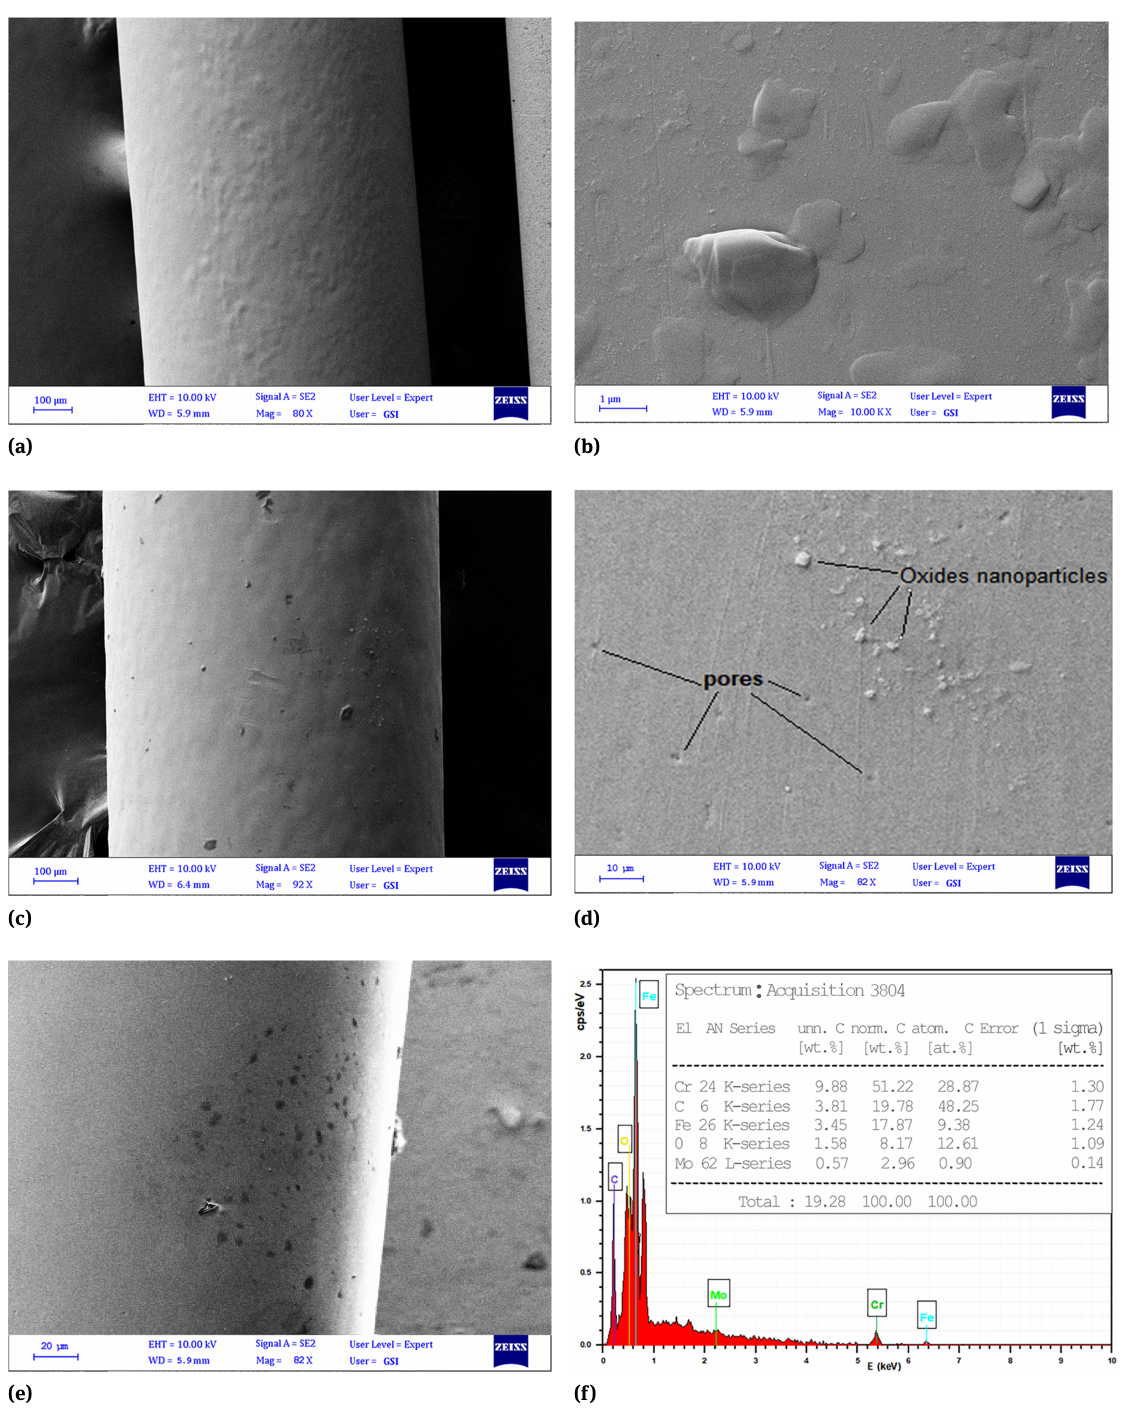
Figure 3: SEM images of anodized SS316L for (a) and (b) 15min. (c) and (d) for 20min (e) for 30min, (f) SEM-EDS spectrum with elemental ration of the selected smooth lump area (sample GE